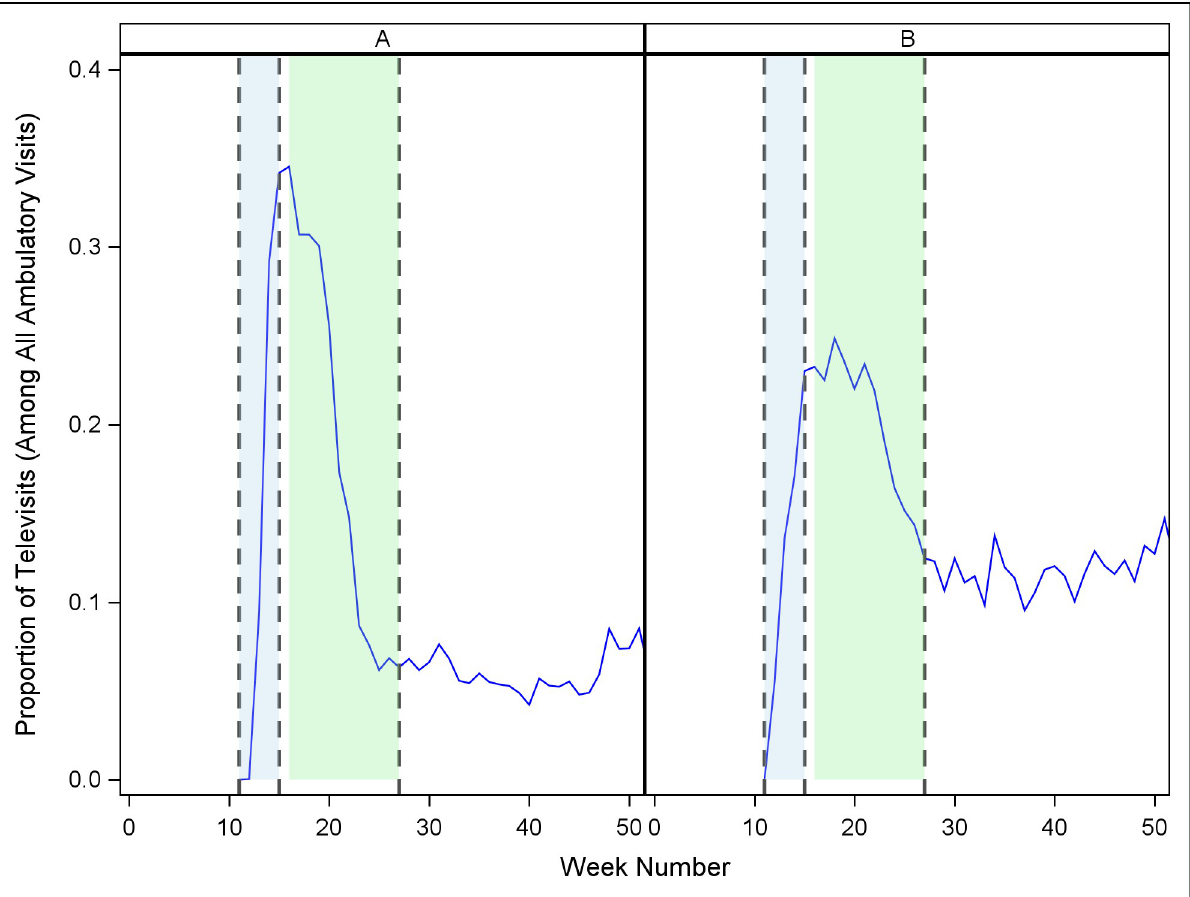
Fig 3. Proportion of 2020 ambulatory visits conducted as televisits, by week, for each site. A = Allegheny Health; B = Johns Hopkins (Vertical reference lines denote periods beginning 3/8/20 (week 11), 4/5/20 (week 15), and 6/28/20 (week 27)).